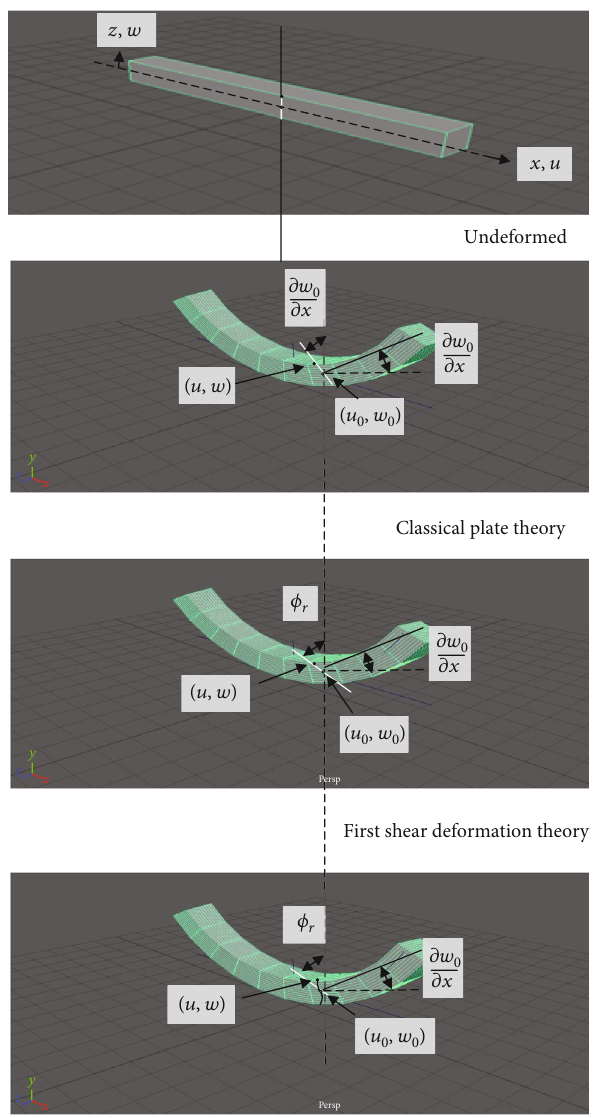
Figure 2: The geometry of annular circular